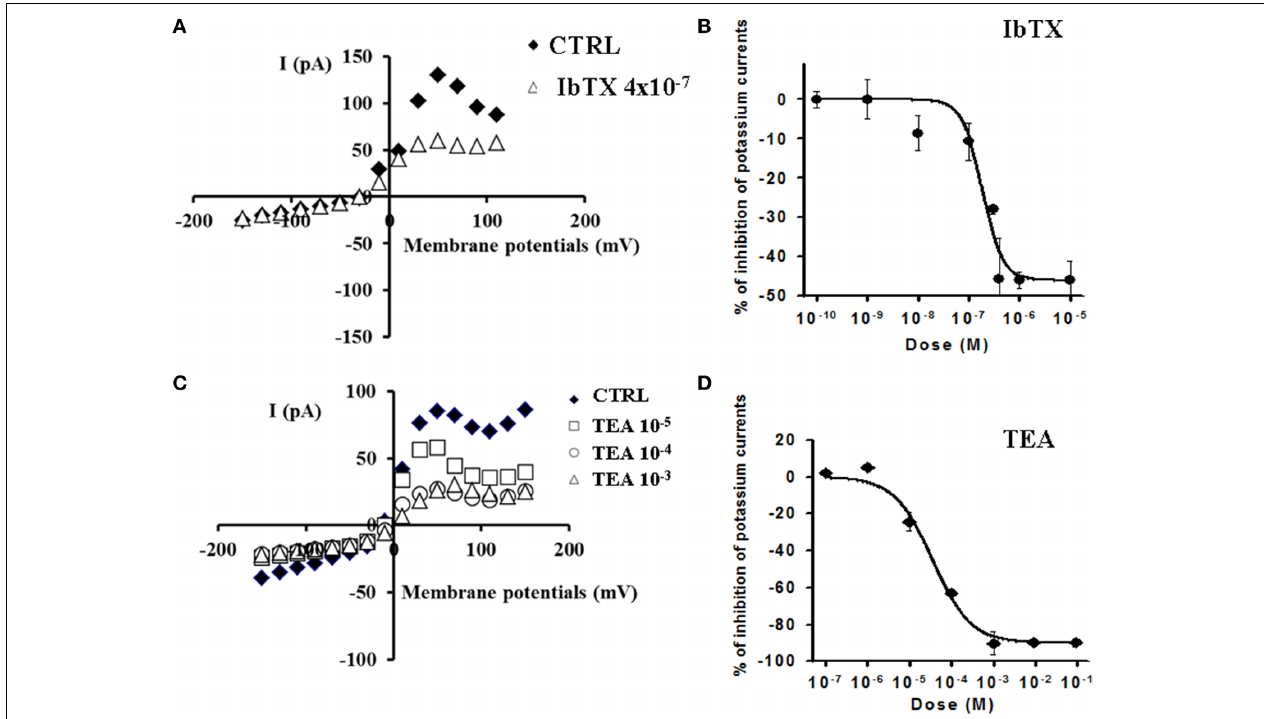
FIGURE 2 | Effects of the BKCa channel blockers IbTX and TEA on K + -current recorded in SH-SY5Y neuronal cell line. The effects of IbTX and TEA were investigated on the K + -current recorded in asymmetrical K + ions concentrations (int K + : 132 × 10 − 3 M; ext K + : 2.8 × 10 − 3 M), in the presence of internal 1.6 × 10 − 6 M concentration of free Ca 2 + ions, in the range of potentials going from − 150 to + 110mV, HP = − 60mV using whole cell patch clamp technique. The whole cell K + -current was a leak subtracted and normalized to capacitance. (A) I/V relationship in the absence or presence of